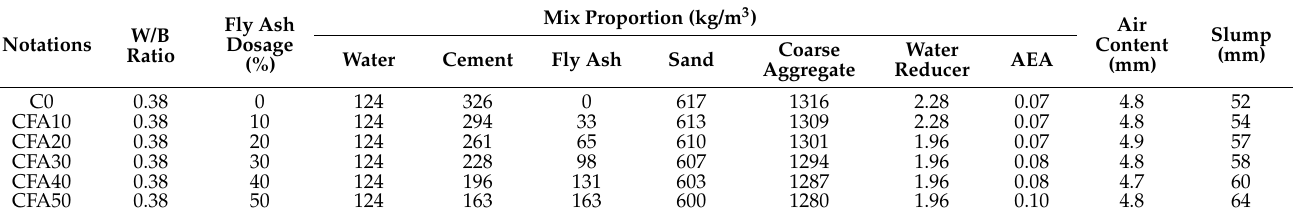
Table 2. Mix proportion of the face slab